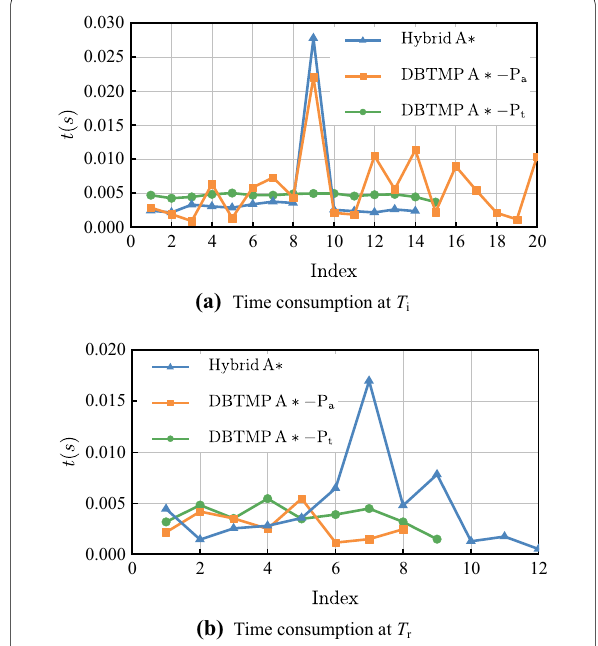
Figure 15 Time consumption of single-step extension of